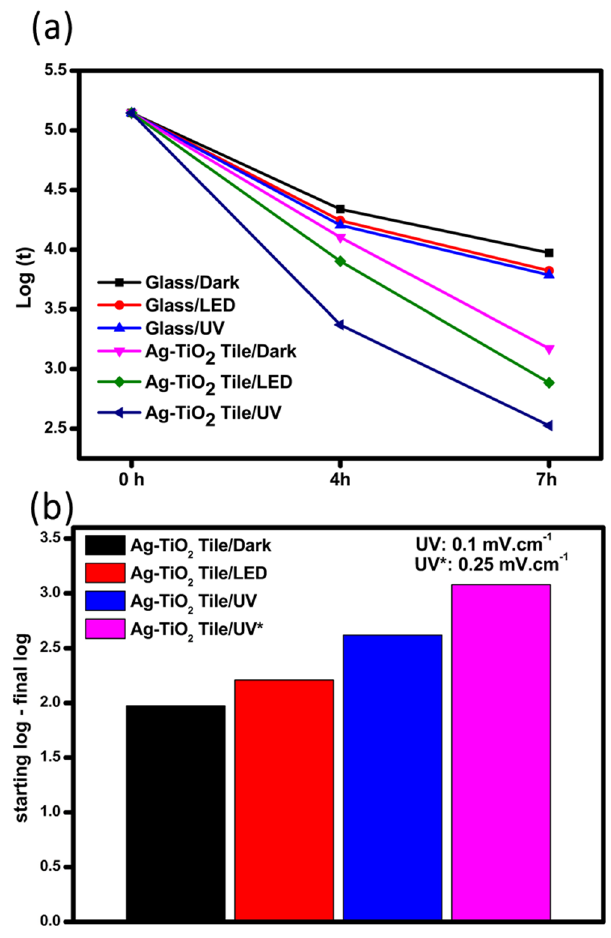
Figure 2. ( a ) Inactivation of SARS-CoV-2 under different conditions (dark, LED, UVA: 0.1 mW/cm) after 4 and 7 h. ( b ) Selected results under different dark/lighting conditions (LED and UVA: 0.1 and 0.25 mW/cm) after 7 h.